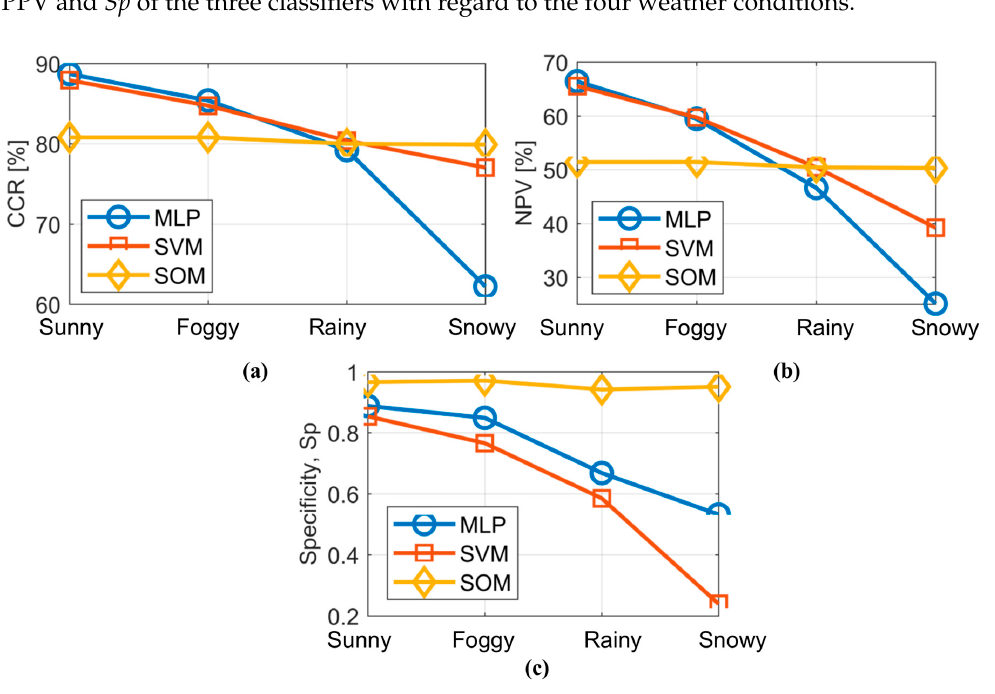
Figure 8. Behaviour of the performance indices for each classifier with regard to weather conditions. ( a ) CCR, ( b ) NPV and ( c ) Sp.